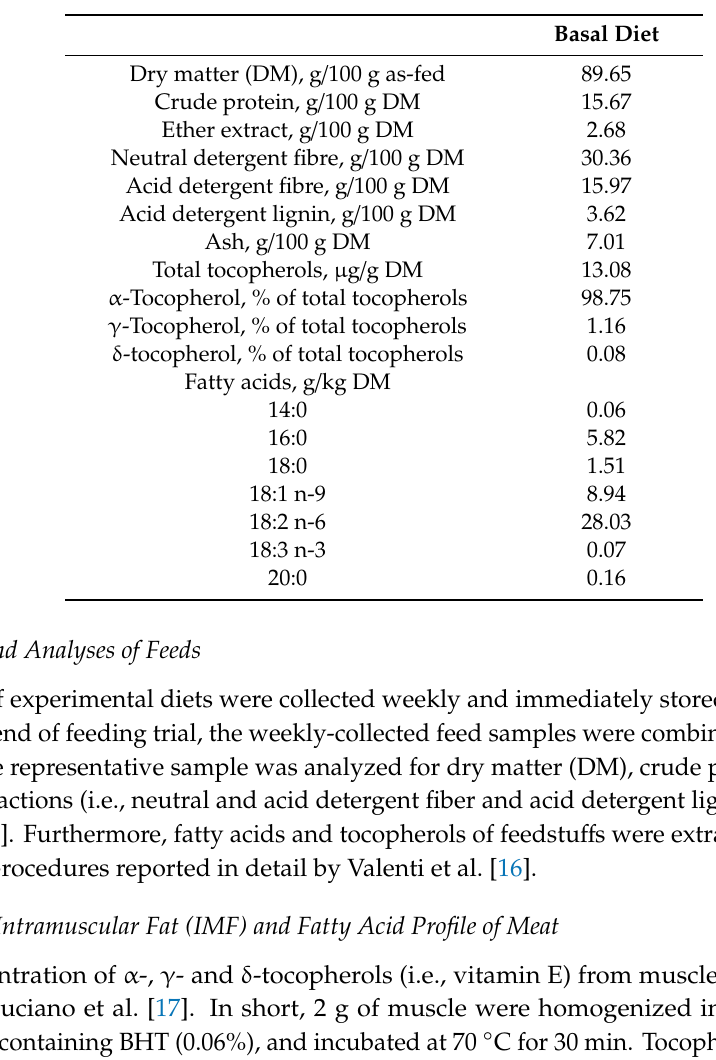
Table 1. Chemical composition of the basal